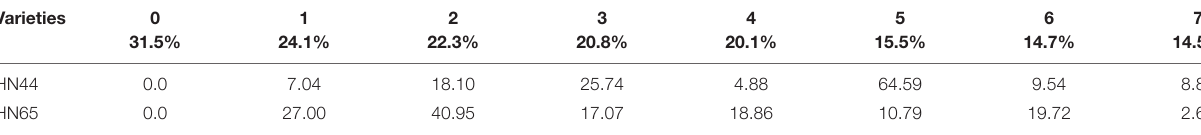
TABLE 2 | Effect of drought on the relative increase rate of MDA content (%). Varieties